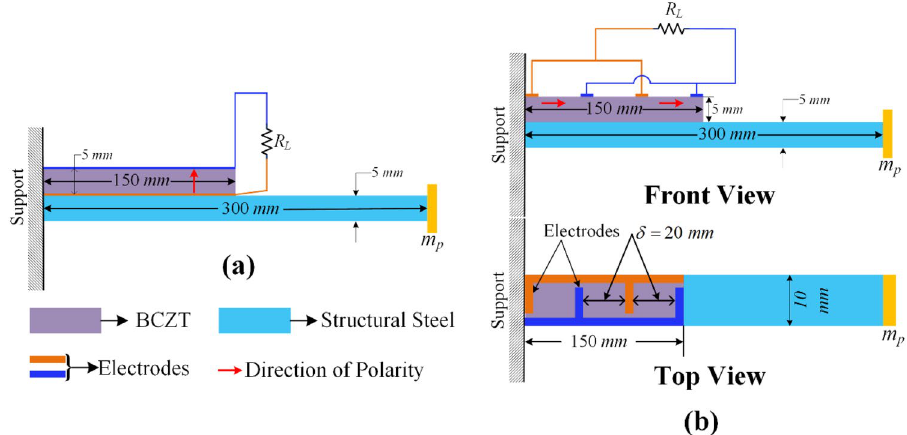
Figure 3. Cantilever beam-based piezoelectric energy harvester operated in ( a ) Transverse mode and ( b ) Longitudinal mode (Front and Top View). “BCZT” in the figure represents 0–3